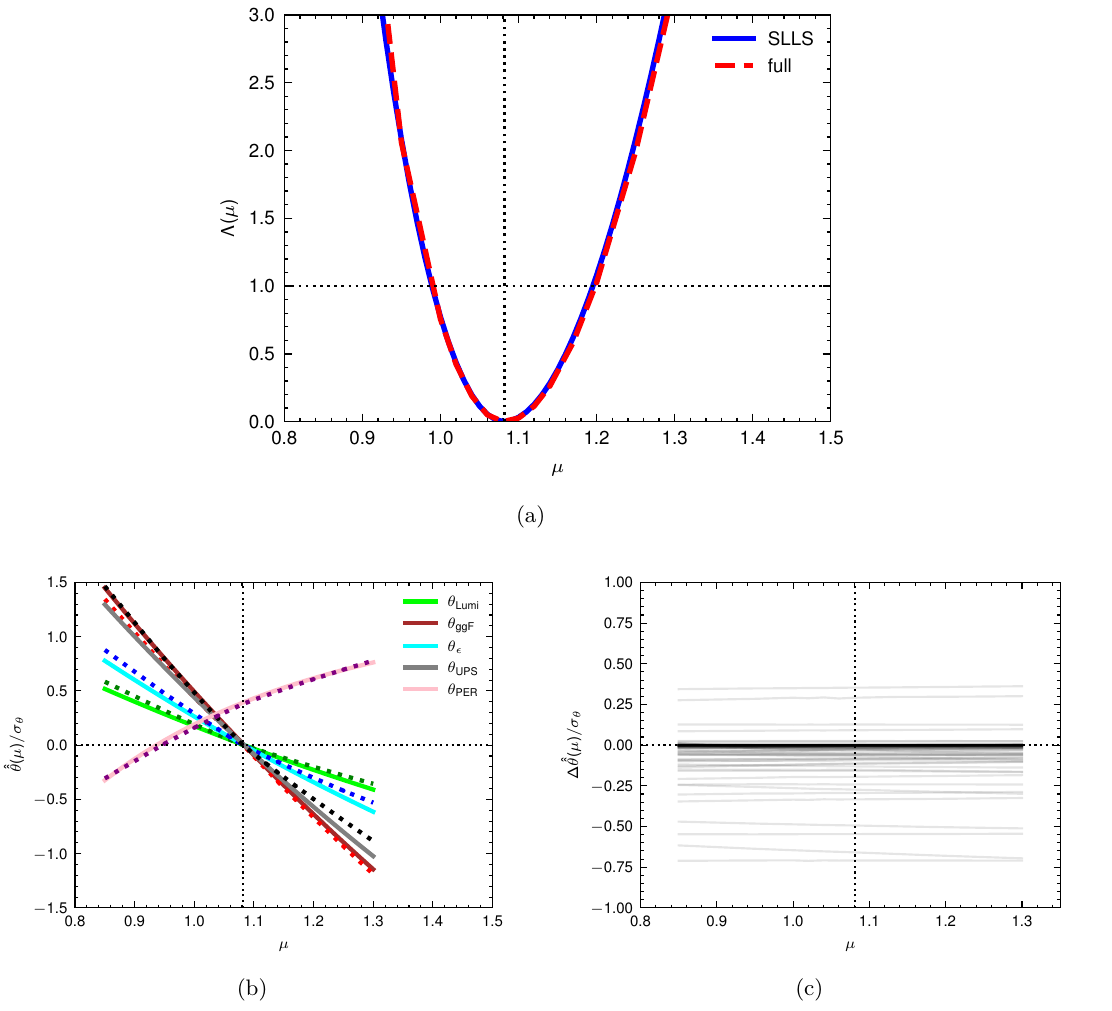
Figure 8 . Comparison between the SLLS model (solid lines) and the full model (dashed lines) for (a) the profile likelihood Λ( µ ) as a function of the POI µ ; (b) the profiled values of a selection of NPs describing systematic uncertainties; and (c) the difference between the profiled values of each NP obtained from the SLLS model and the full model, divided by its uncertainty in the full-model fit to the data with free µ